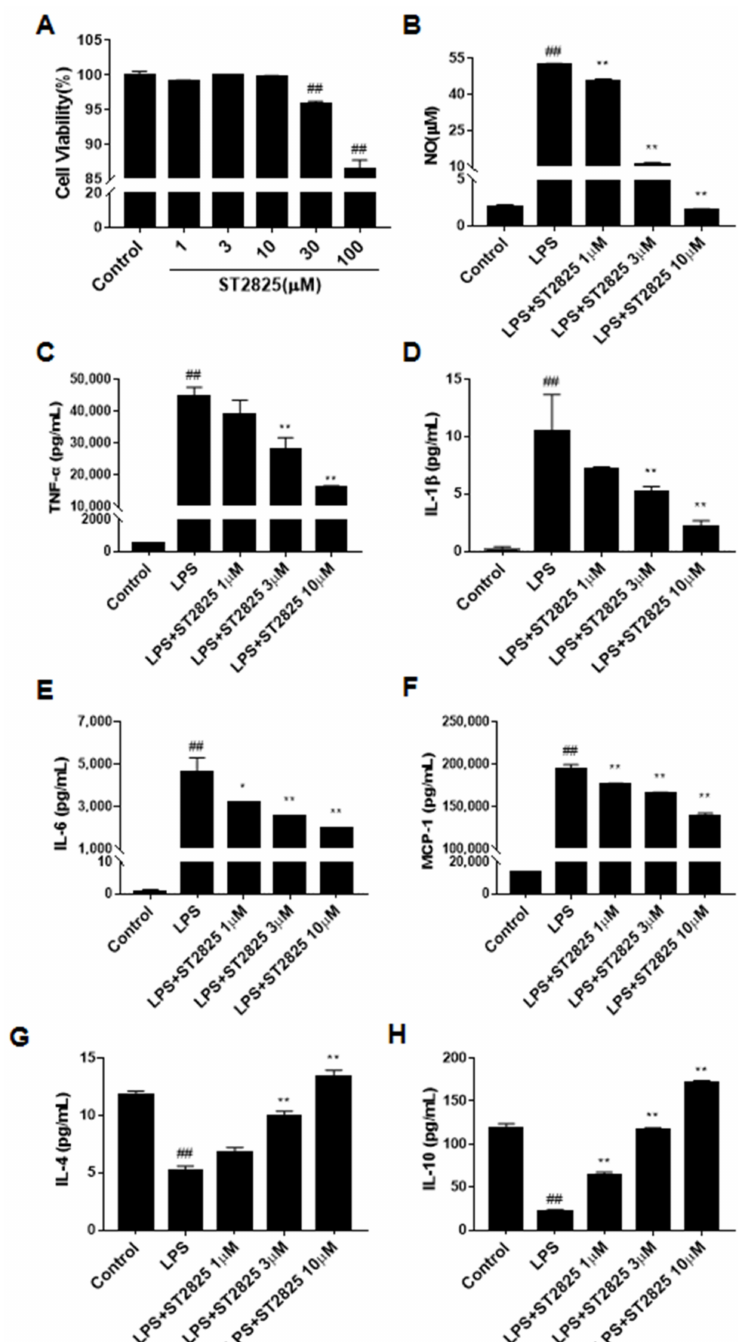
Figure 3. Effects of ST2825 on LPS-induced pro-inflammatory factors in BV2 cells. ( A ) Cell viability of ST2825 on BV2 microglia cells. ( B ) Effect of ST2825 on NO production. The levels of ( C ) TNF- α , ( D ) IL-1 β , ( E ) IL-6, ( F ) MCP-1, ( G ) IL-4 and ( H ) IL-10 in the culture supernatant were assessed by ELISA. Values are mean ± SEM ( n = 3). ## p < 0.01 vs. control group; * p < 0.05, ** p < 0.01 vs. LPS